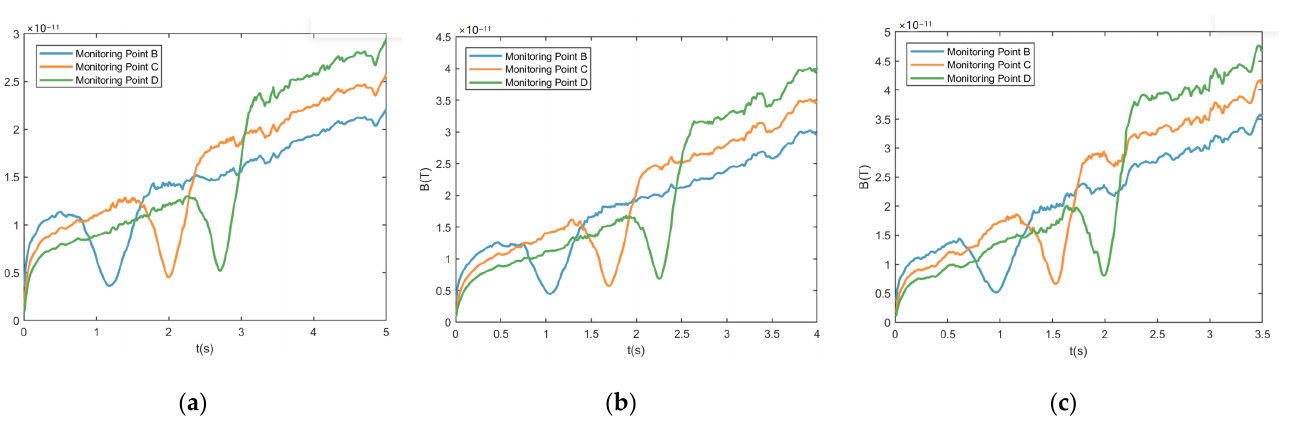
( c ) Figure 15. The time domain contrast diagram of the magnetic field at the same monitoring point when the submarine moved with different accelerations. Monitoring points ( a ) B, ( b ) C, and ( c ) D. As the wake of the underwater vehicle at monitoring point A is fully developed, the influence of acceleration on the wake magnetic field was analyzed. Figure 16 shows the variation in the magnetic field with time under different accelerations at monitoring point